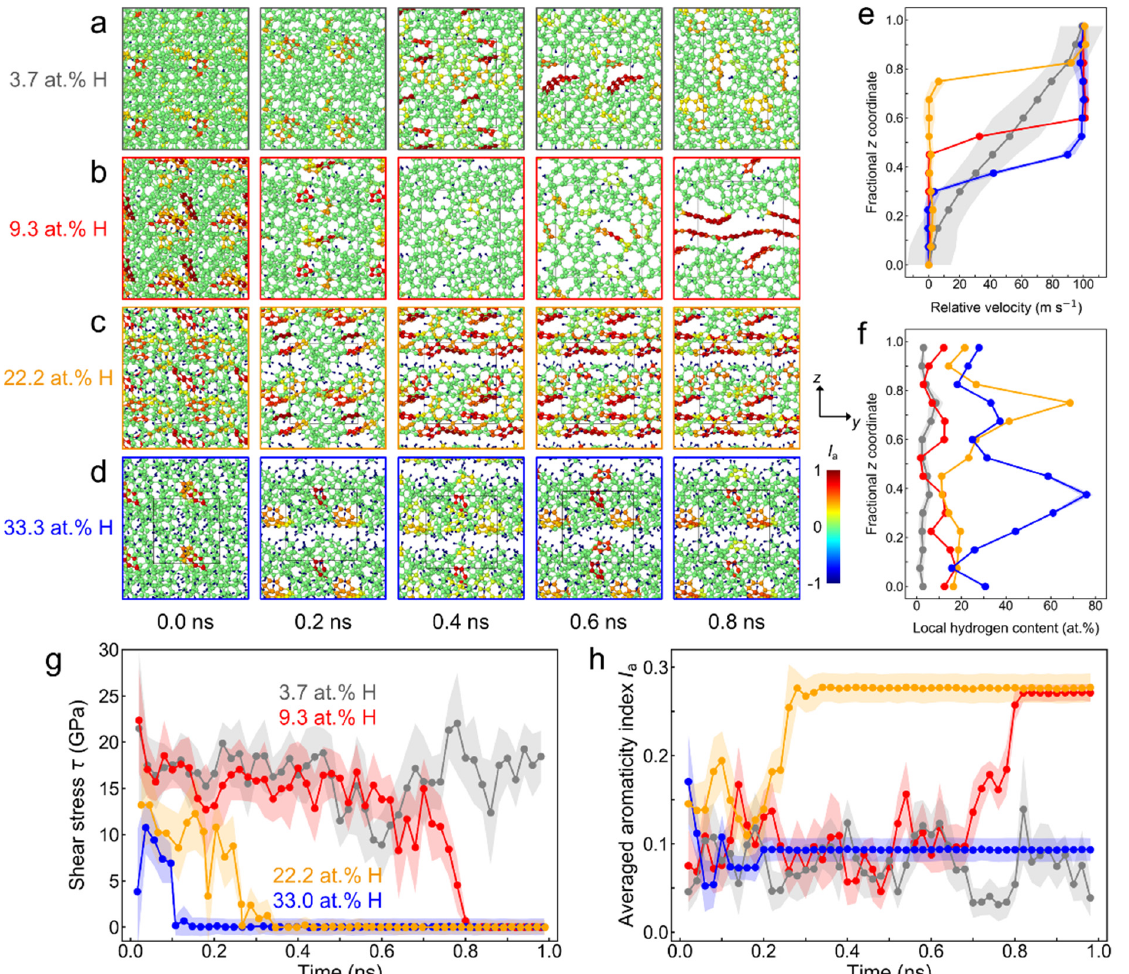
Figure 1. DFTB MD simulations of bulk a-C:H with the Lees-Edwards boundary conditions for 1 ns. Structural evolutions of the a-C:H samples with ( a ) 3.7, ( b ) 9.3, ( c ) 22.2, and ( d ) 37.0 at.% H. The carbon atoms are colored according to aromatization index ( I a , 0 ≤ I a ≤ 1 ) analysis for each 5- and 6-membered ring. I a = − 1 is assigned to all hydrogen atoms (represented by blue spheres). All snapshots are side ( yz ) views of the simulation systems. In the panels ( a – d ), the simulation cells are replicated periodically in all directions. The unit cells are indicated by gray rectangles. Profiles of ( e ) velocities along the x -axis and ( f ) local hydrogen contents during the last 0.1 ns for the four representative MD trajectories of a-C:H with 3.7 (gray), 9.3 (red), 22.2 (orange), and 33.3 (blue) at.% H. Semi-transparent regions represent standard deviations. Time evolutions of ( g ) shear stresses τ and ( h ) averaged aromaticity indices I a . I a is defined as ∑ n C i -th carbon atom, and n C is the number of carbon atoms in each system. Values of τ and I a are computed as 2-ps averages, and they are further averaged every 20 ps. Semi-transparent regions represent standard deviations of the 20-ps